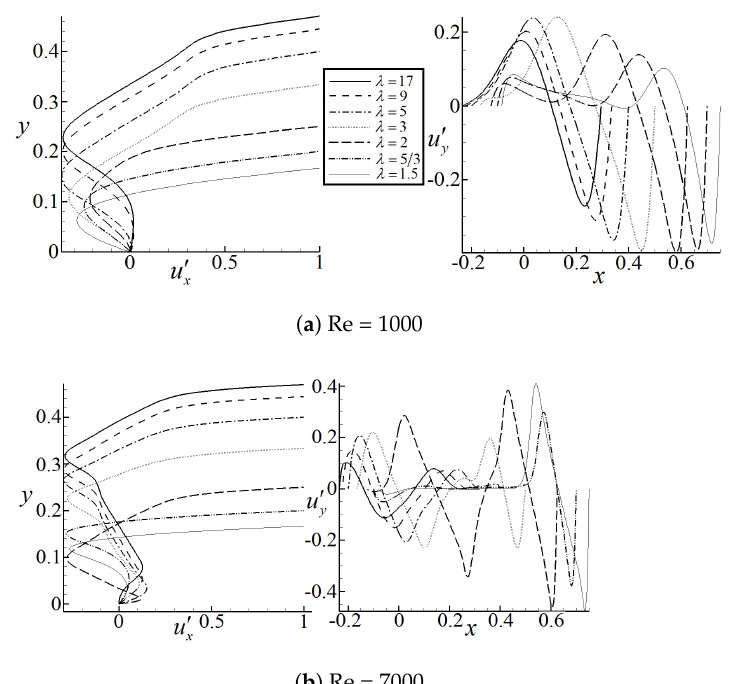
Figure 9. Normalized velocity profiles along the vertical and horizontal central lines for different values of λ .